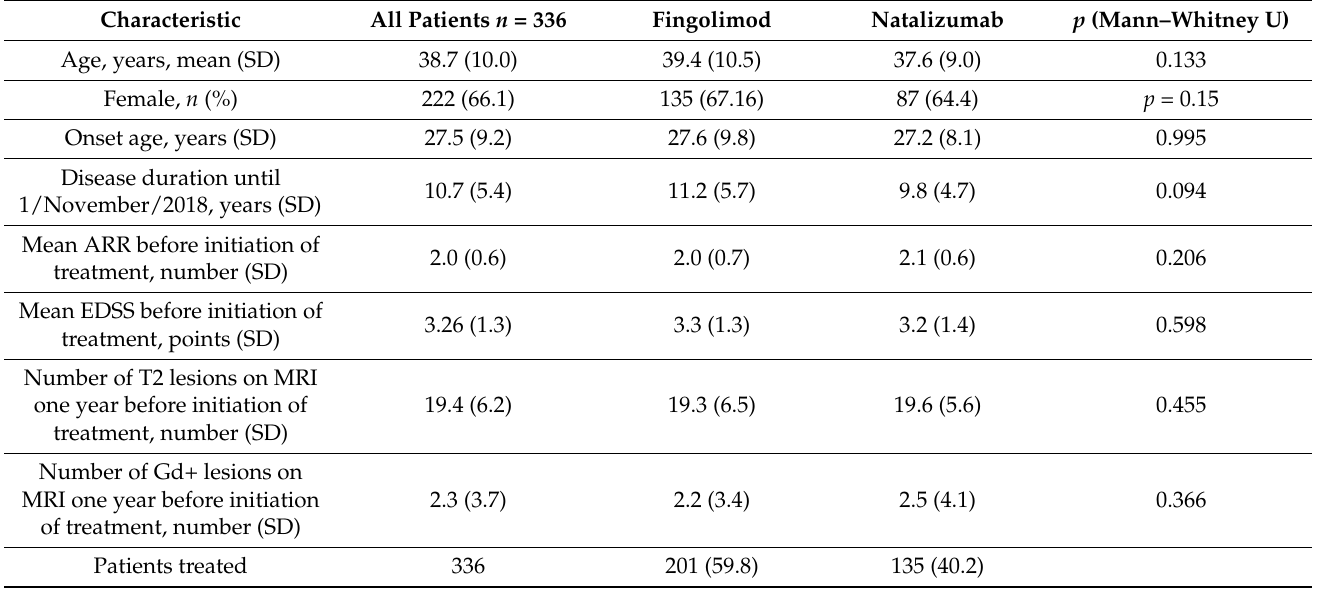
Table 2. Baseline demographic and clinical characteristic of patients treated with fingolimod and natalizumab. Characteristic All Patients n = 336 Fingolimod Natalizumab p (Mann–Whitney